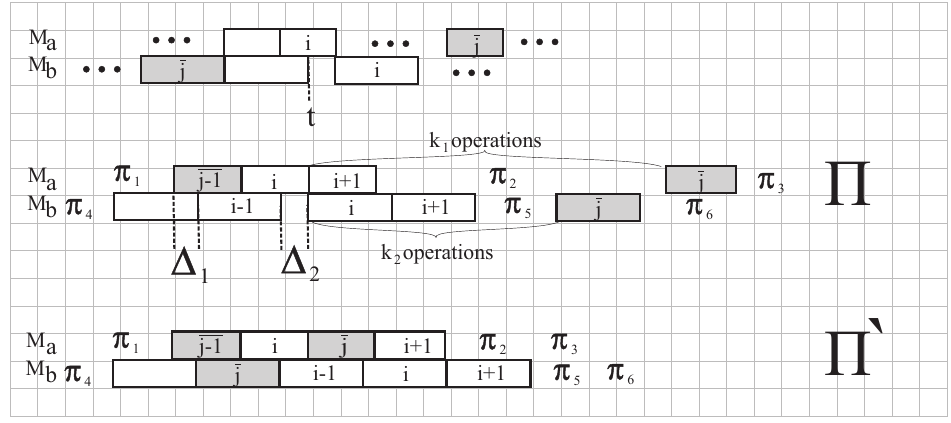
Figure 3. Illustration for the proof of Theorem